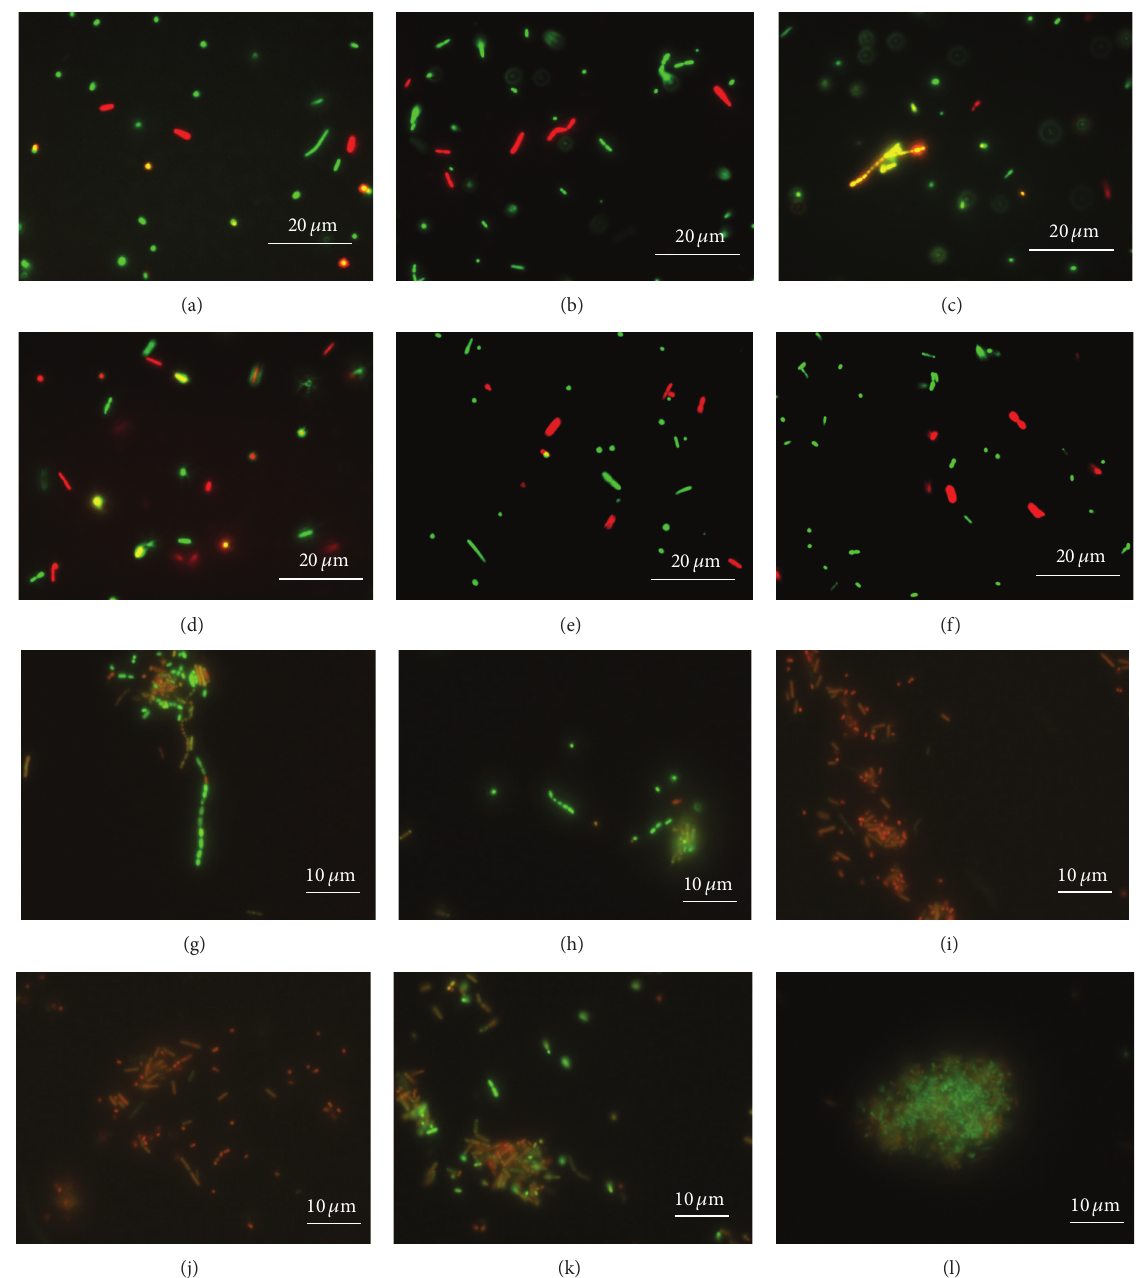
Figure 2: Fluorescence images illustrating cell viability of M. ruminantium cell suspensions exposed to different saturated fatty acids provided in a concentration of 10 𝜇 g/mL in K + -free buffer and stained with the LIVE/DEAD BacLight Kit (Experiment 3). Green and red cells represent living and dead cells, respectively. Yellow cells were not categorized as living but included in total cell counts. (a–f) Images taken 3h after SFA supplementation; (g–l) Images taken after 24 h. The images selected are representative for blank (a, g), control (b, h), C 12 (c, i), C 14 (d, j), C 16 (e, k), and C 18 (f,